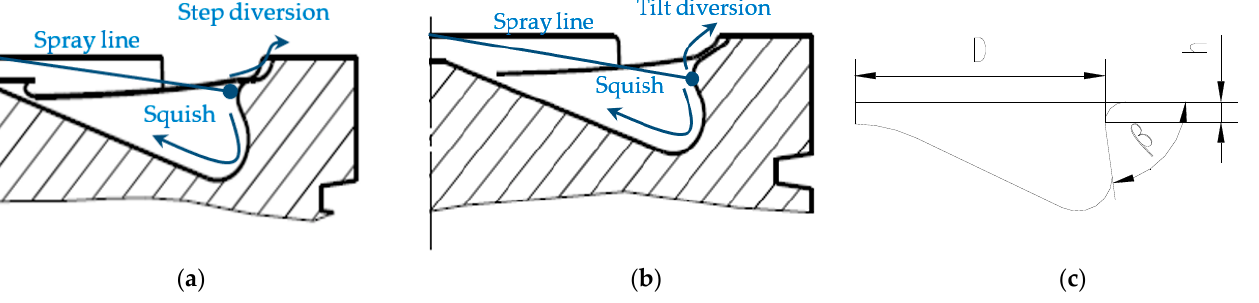
Figure 1. RCSL, RCTL chamber and parameter definition. ( a ) Re-entrant combustion chamber with step-typed lip (RCSL); ( b ) re-entrant combustion chamber with tilted lip (RCTL); ( c ) parameters combustion chamber. Table 1. Parameter range of test combustion